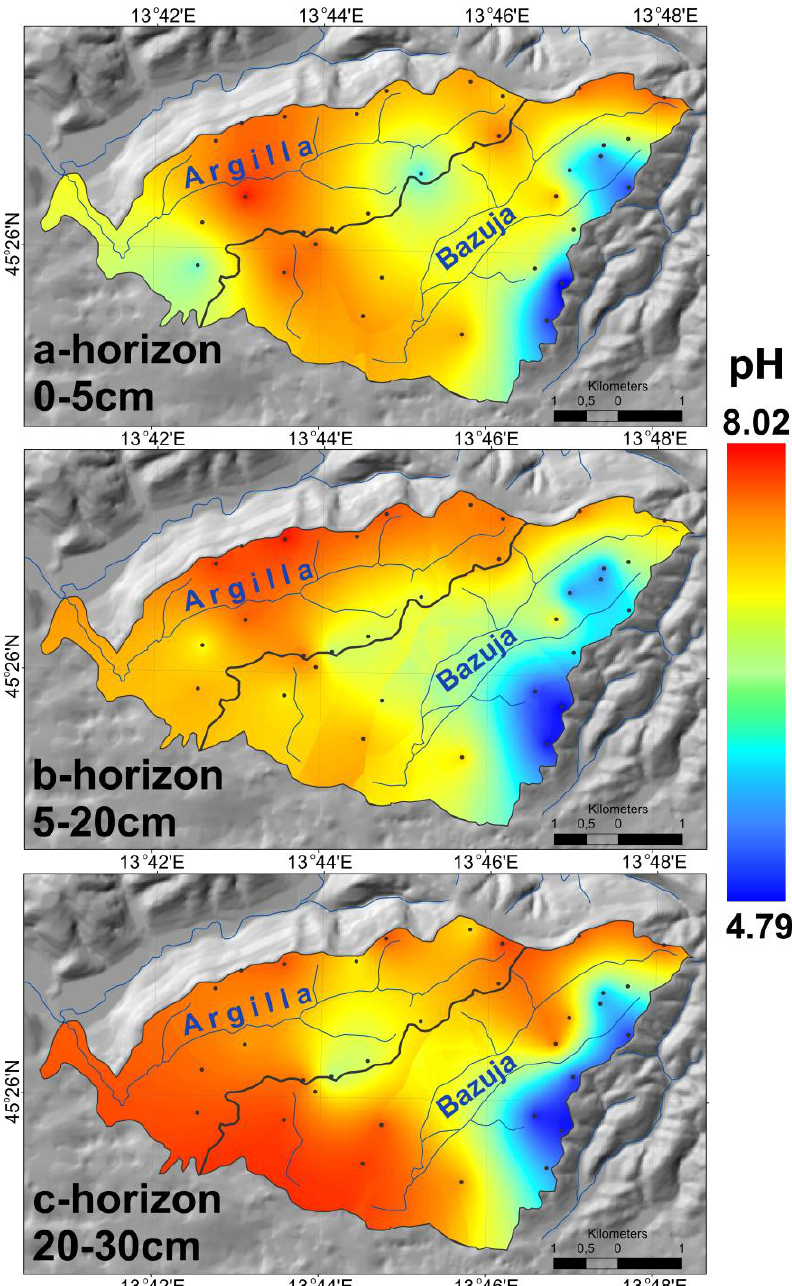
Figure 9. Soil pH (H2O) in a, b, and c horizons in both catchments.